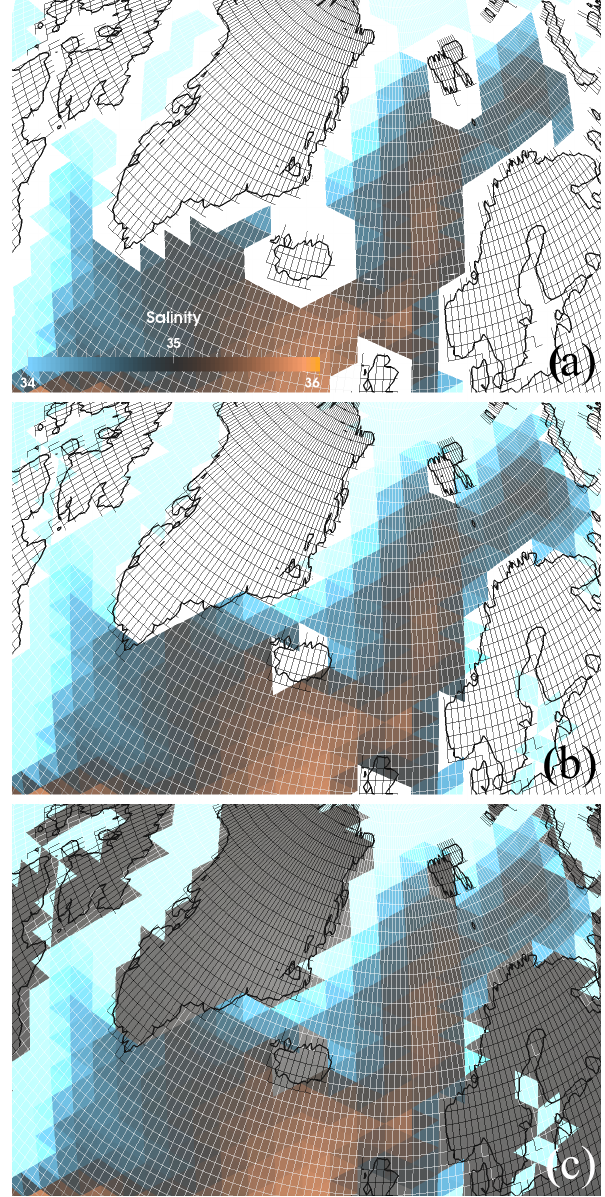
Figure 1. WOA09 January monthly mean sea surface salinity given on white rectangles interpolated to an ICON grid (triangles) using the YAC interpolation stack with first-order conservative remap- ping (a) plus first-order polynomial fit (b) and plus fixed values (c) (for further details see Sect.